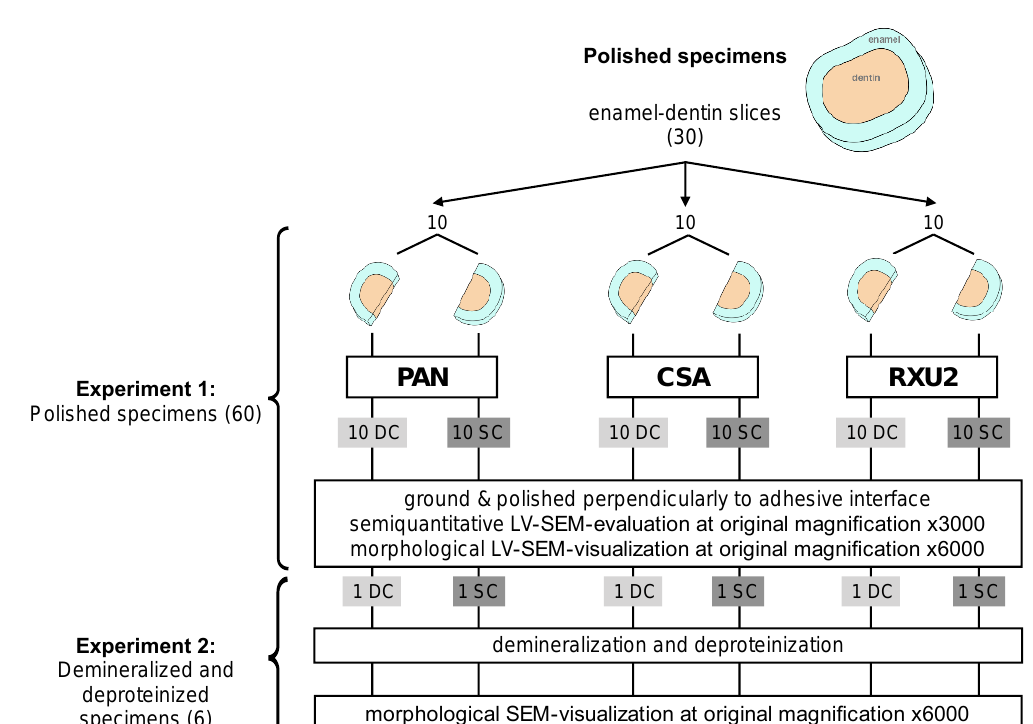
Figure 1. Allocation of enamel dentin slices for experiment 1 (polished specimens) and experiment 2 (demineralized and deproteinized specimens). For Panavia F 2.0 (PAN), Clearfil SA Cement (CSA) and RelyX Unicem 2 (RXU2), the two semicircular specimens arising from the same tooth were allocated to dual-curing mode (DC) and self-curing mode (SC). Specimens were evaluated and visualized using low vaccum scanning electron microscopy (LV-SEM) under low voltage conditions.